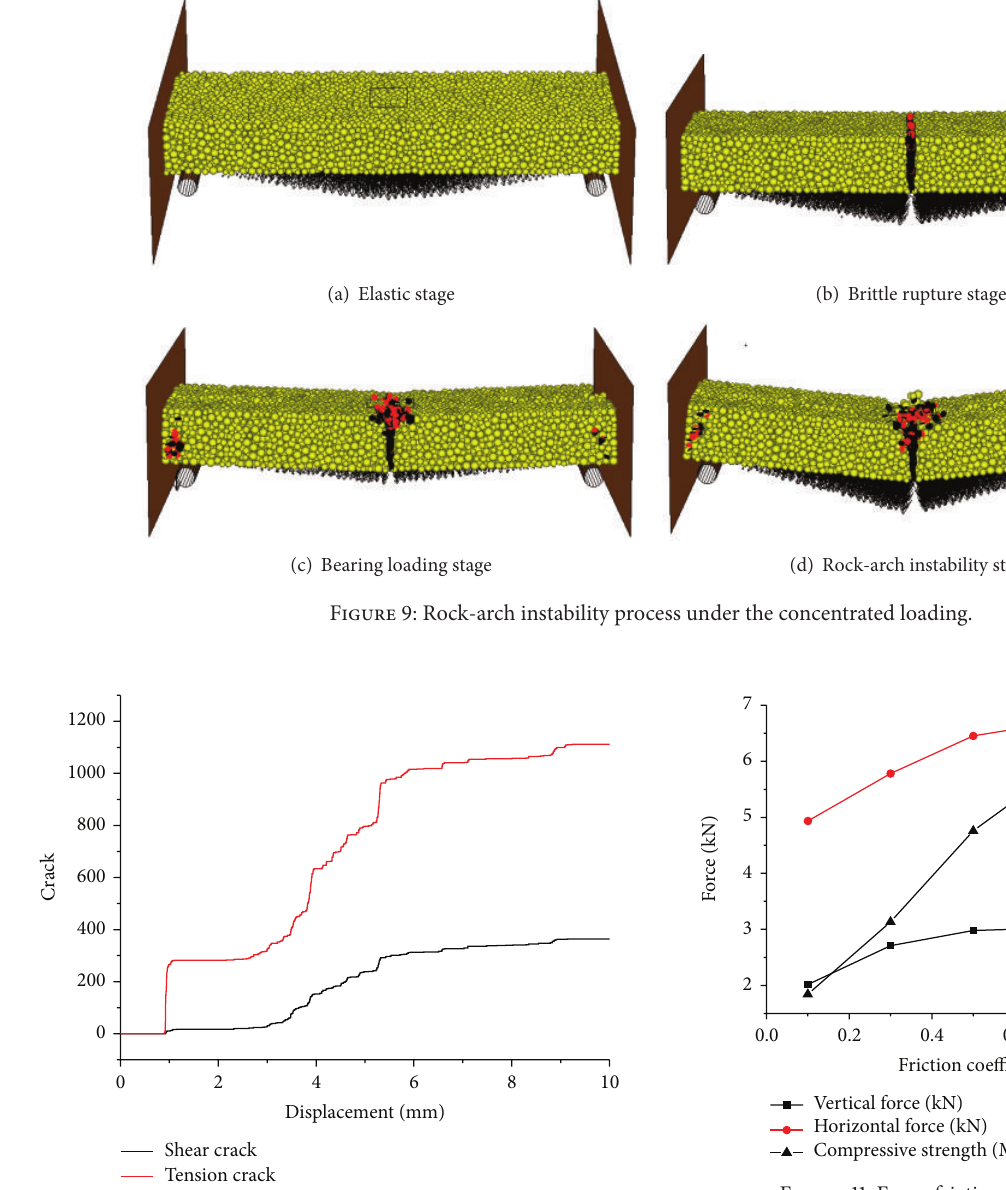
Figure 11: Force-friction coefficient